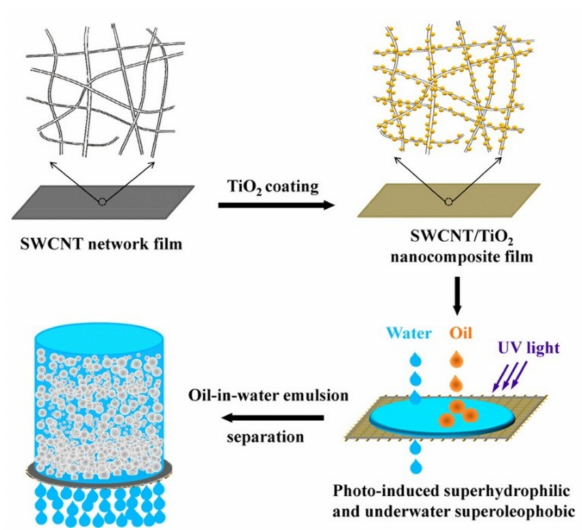
Figure 5. Schematic showing the preparation process of the SWCNT/TiO 2 nanocomposite film and for separation of an oil-in-water emulsion. Reprinted with permission from [75]. Copyright (2014) American Chemical